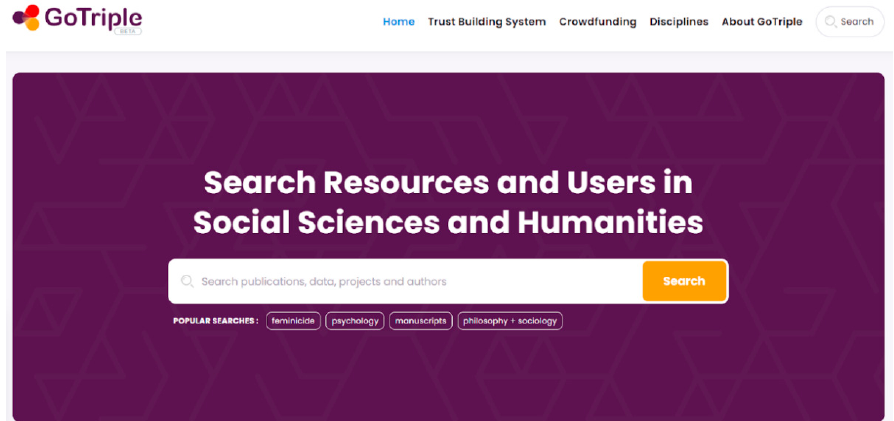
Figure 1. The home page of GoTriple with the search engine. A beta prototype of GoTriple was